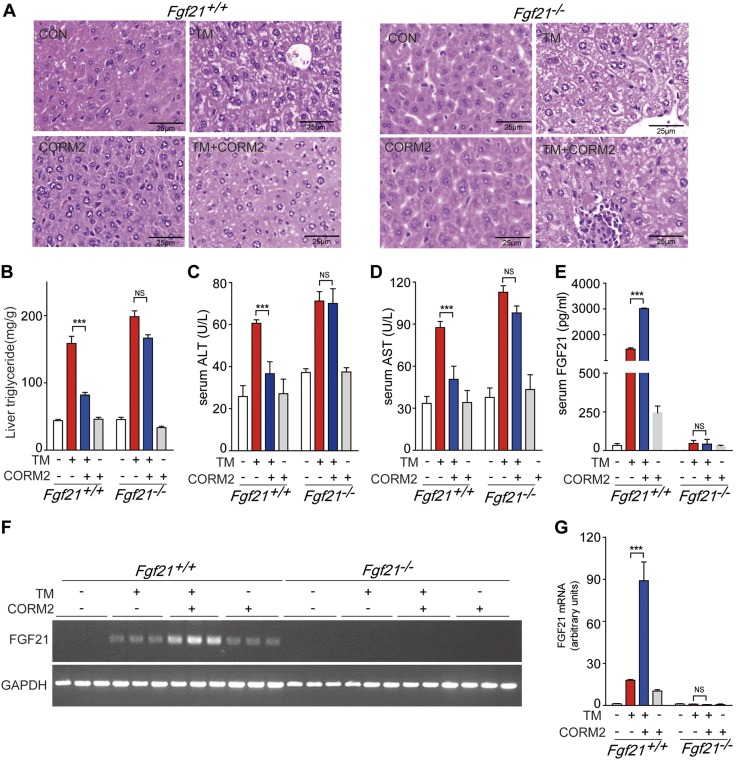
CO protects against ER stress-induced hepatic steatosis by induction of FGF21 expression. A) 6-wk-old Fgf21+/+ and Fgf21−/− mice were pretreated with or without CORM2 (20 mg/kg) or RuCl2 as control for ruthenium, for 6 h, followed by Tm (1 mg/kg) challenge. After 24 h, the mice were euthanized, and liver tissues were extracted and analyzed by H&E staining. B–D) Liver triglyceride (B), serum ALT (C), and AST (D) levels were measured after stimulation with Tm. E) Serum FGF21 levels were detected by ELISA. F, G) The mRNA expression of FGF21 in liver tissues was measured by RT-PCR (F) and qRT-PCR (G). Data are presented as means ± sem (n = 3). NS, not significant. ***P < 0.001.